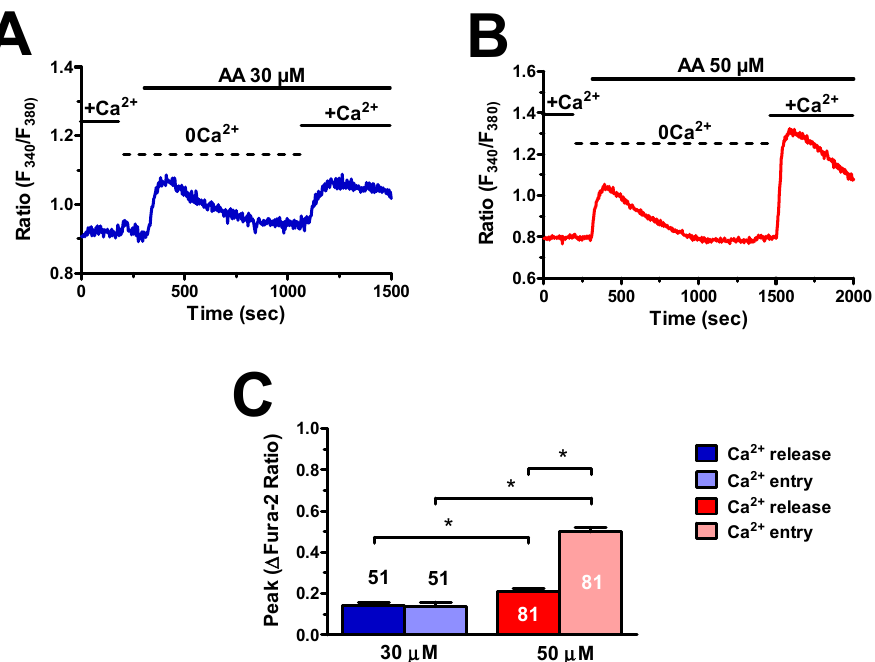
Figure 3. Arachidonic acid induces endogenous Ca 2+ release and extracellular Ca 2+ influx in hCMEC/D3 cells . ( A ) 30 μ M AA evoked endogenous Ca 2+ release under absence of extracellular Ca 2+ (0Ca 2+ ) conditions followed by a second increase in [Ca 2+ ] i upon Ca 2+ restitution to the bath in the continuous presence of the agonist. ( B ) 50 μ M AA evoked endogenous Ca 2+ release under 0Ca 2+ conditions followed by a second increase in [Ca 2+ ] i upon Ca 2+ restitution to the bath in the continuous presence of the agonist. ( C ) Mean ± SE of the amplitude of endogenous Ca 2+ release and extracellular Ca 2+ influx induced by each concentration of AA. The asterisk indicates p < 0.05.